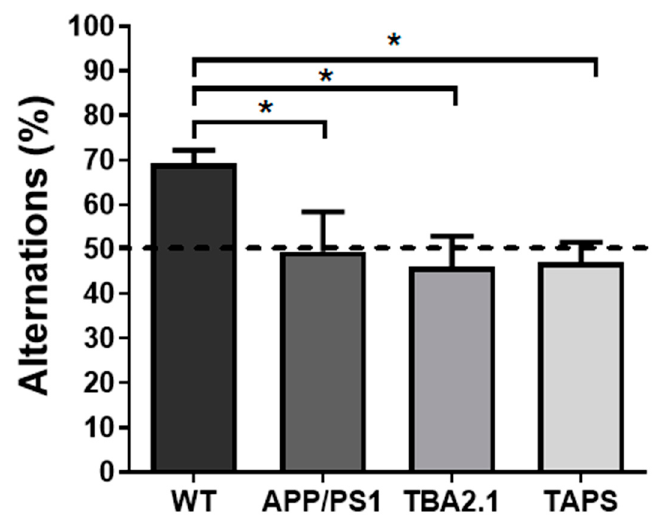
Figure 8. Deficit in spontaneous alternation of TBA2.1, APP/PS1, and TAPS mice in the T-maze. The spontaneous alternation was calculated as the ratio of entries into the correct arm to the amount of total trials in the T maze. With 20 months of age, the APP/PS1 (* p = 0.0349; n = 6), TAPS (* p = 0.0349; n = 6), and TBA2.1 (* p = 0.0145; n = 10) mice alternated significantly less than the wild-type (WT; n = 10) mice. Dashed line indicates threshold of chance (50%). For statistical analysis, one-way ANOVA with Holm-Sidak’s post-hoc was used to compare the genotypes. Data is given as mean + SEM.